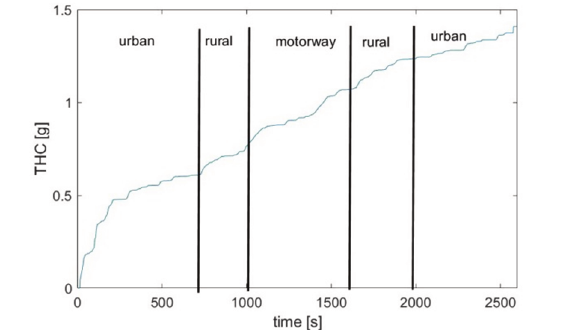
Fig, 12. Correlation between NO x emission intensity and velocity and acceleration of Euro 3 LPG fuelled